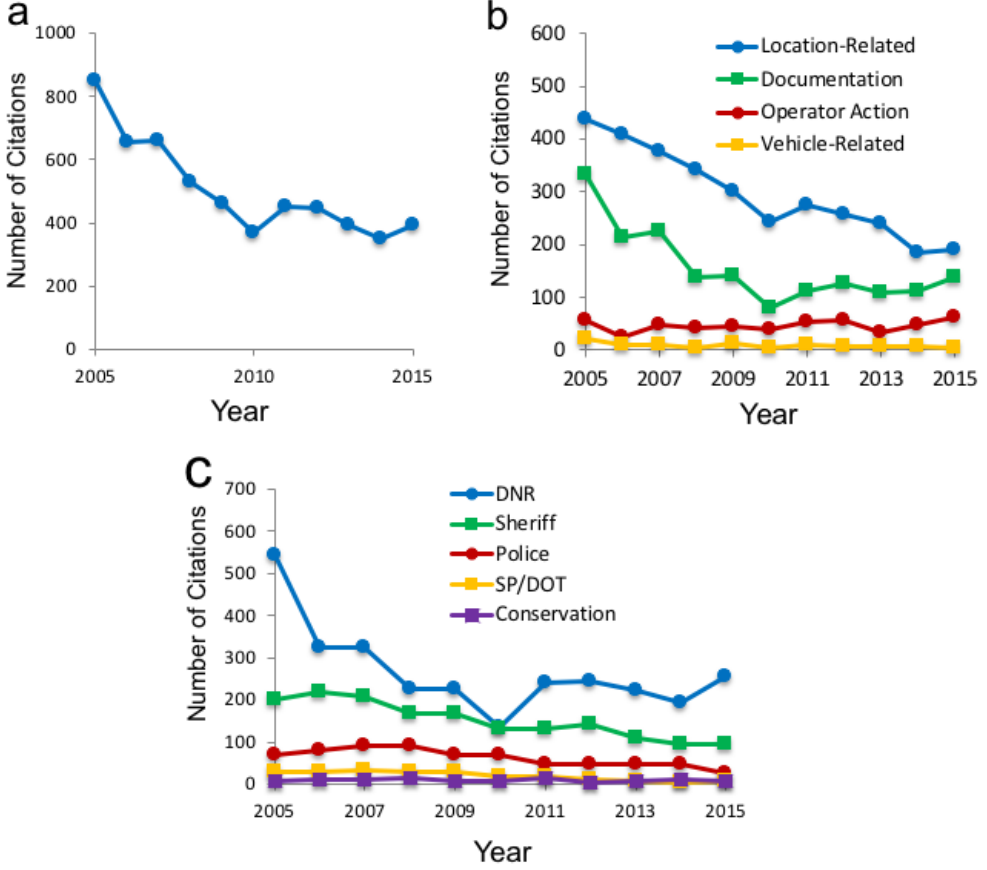
Figure 1. Graphs of citations issued over time. Number of ORV-related citations over time: ( a ) All citations, ( b ) by citation type, and ( c ) by enforcement agency. Abbreviations: DNR, Department of Natural Resources; SP / DOT, State Patrol / Department of Transportation.